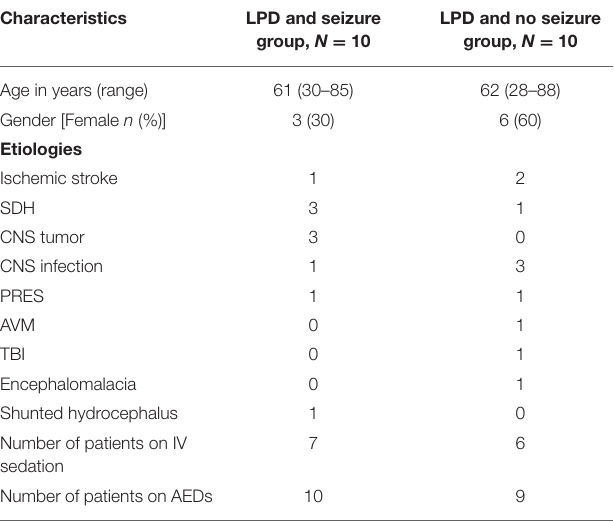
TABLE 4 | Comparison of LPD features between epochs containing seizures ( N = 23) and epochs without seizures ( N = 77) for 10 patients with seizures.